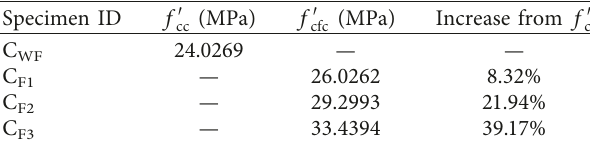
Table 8: Increase of peak stresses.